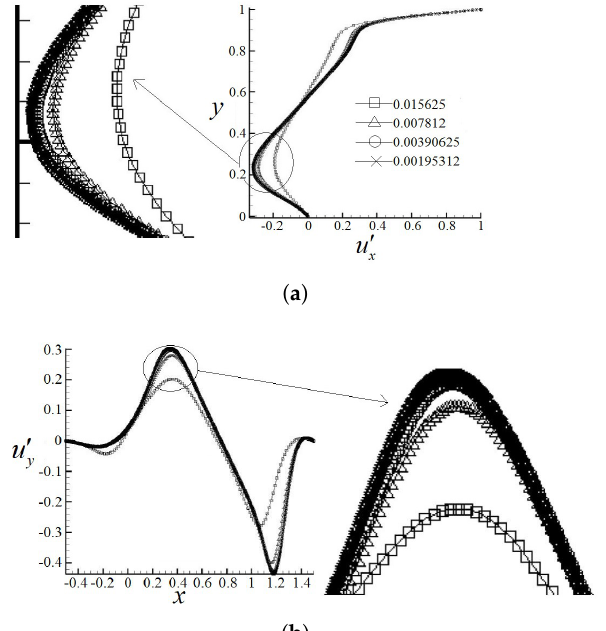
Figure 6. Velocity profiles along the vertical ( a ) and horizontal ( b ) central lines with different